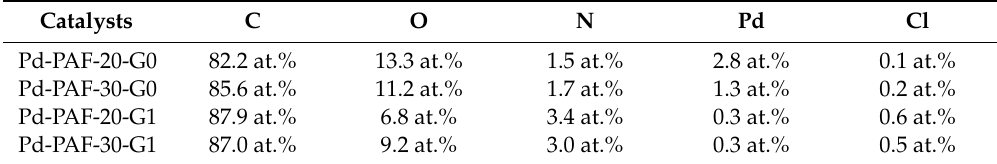
Table 4. Components of the XPS spectra.